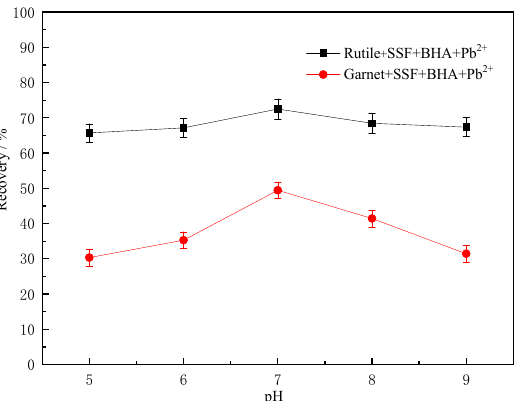
Figure 7. Effect of pH on rutile and garnet activated by Pb 2+ (concentration of BHA and SSF = 40 mg/L, concentration of Pb 2+ = 10 mg/L).